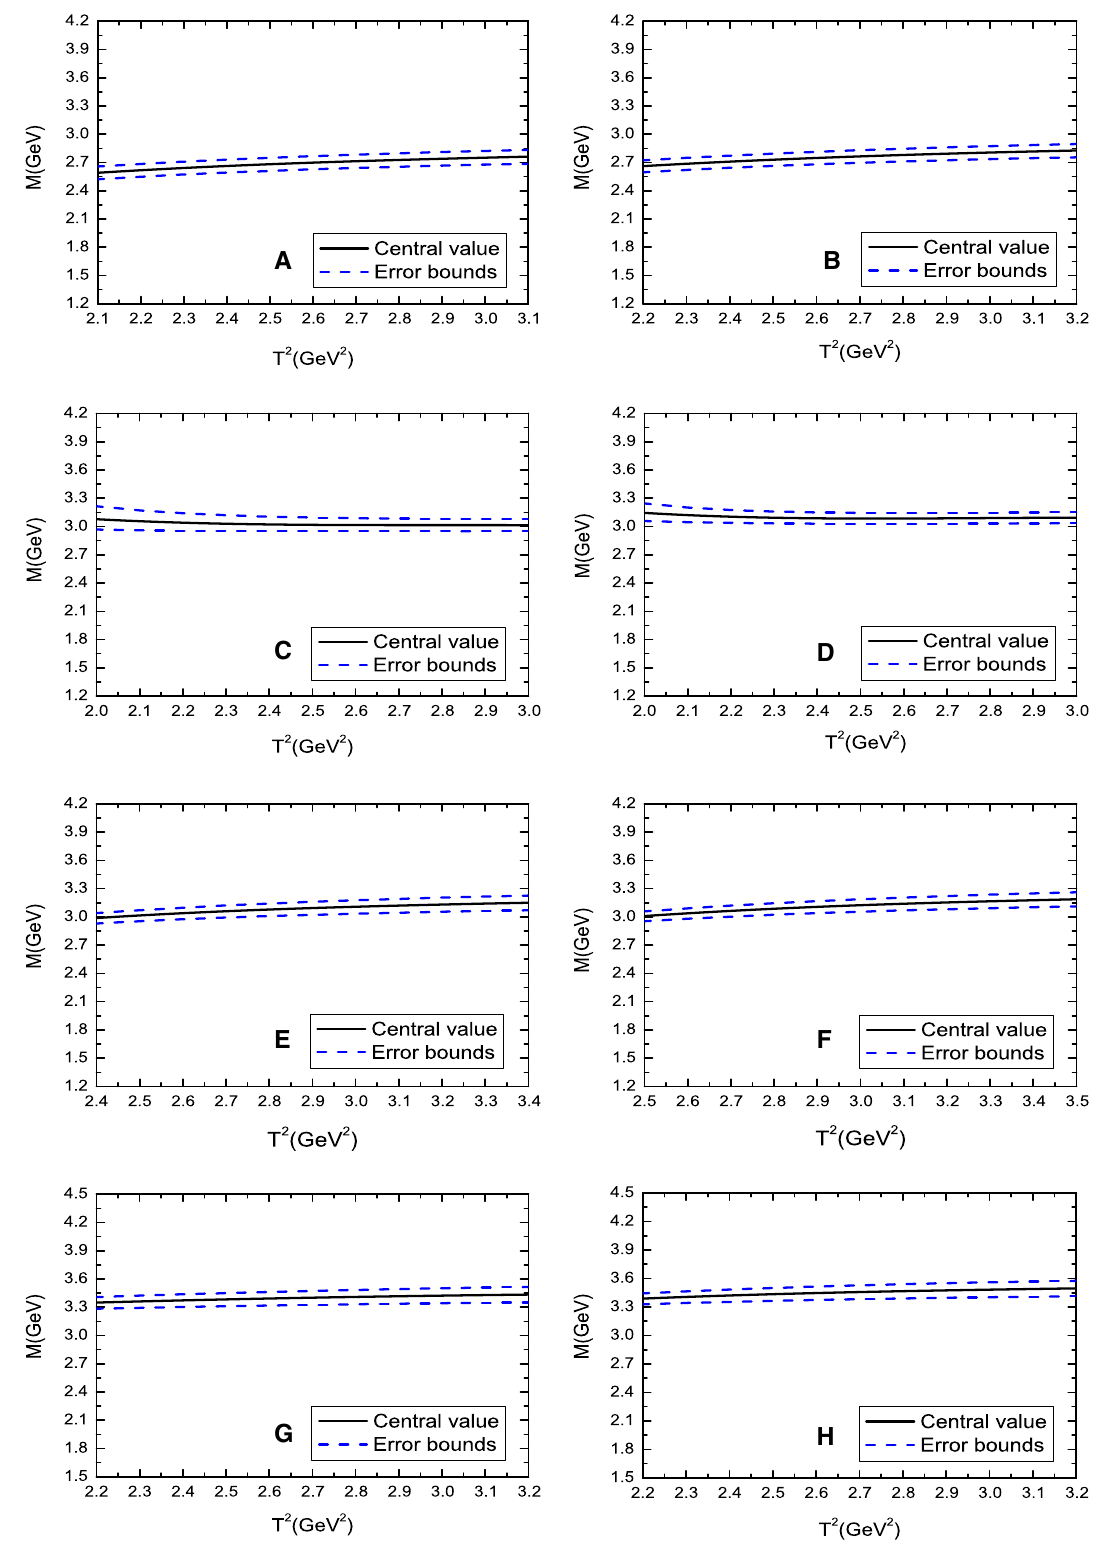
Fig. 3 The masses of the (cid:2) c states with variations of the Borel parameters T 2 , where A , B , C , D , E , F , G and H correspond to the (cid:2) c states with the quantum numbers ( 1S , 1